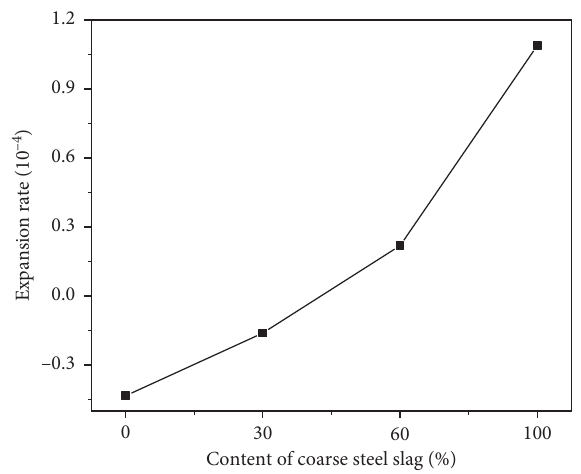
Figure 18: The impact of the content of coarse steel slag sand on the expansion rate of the FSSAC.